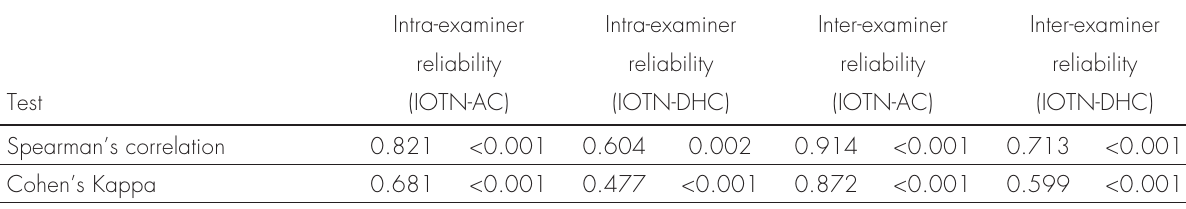
Table I. Inter and intra examiner reliability for orthodontist IOTN scores.